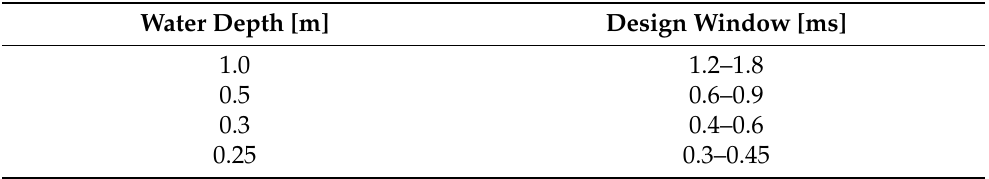
Table 1. Overview of applied parameters for spiking deconvolution in VISTA seismic data process- ing